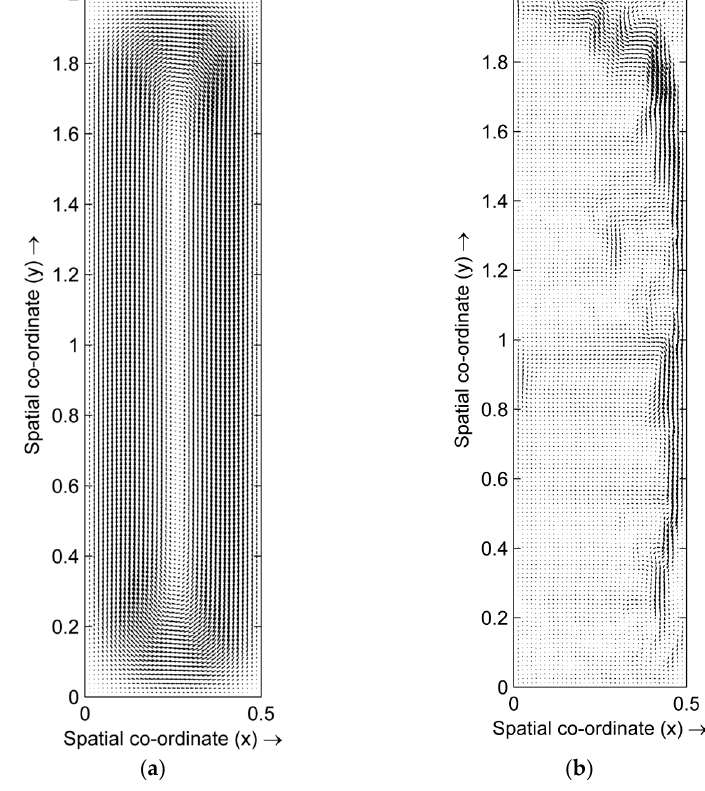
Figure 2. Flow velocity field in cooling Cu-Pb melts under 0 T and 12 T. ( a ) 0 T; and ( b ) 12 T.